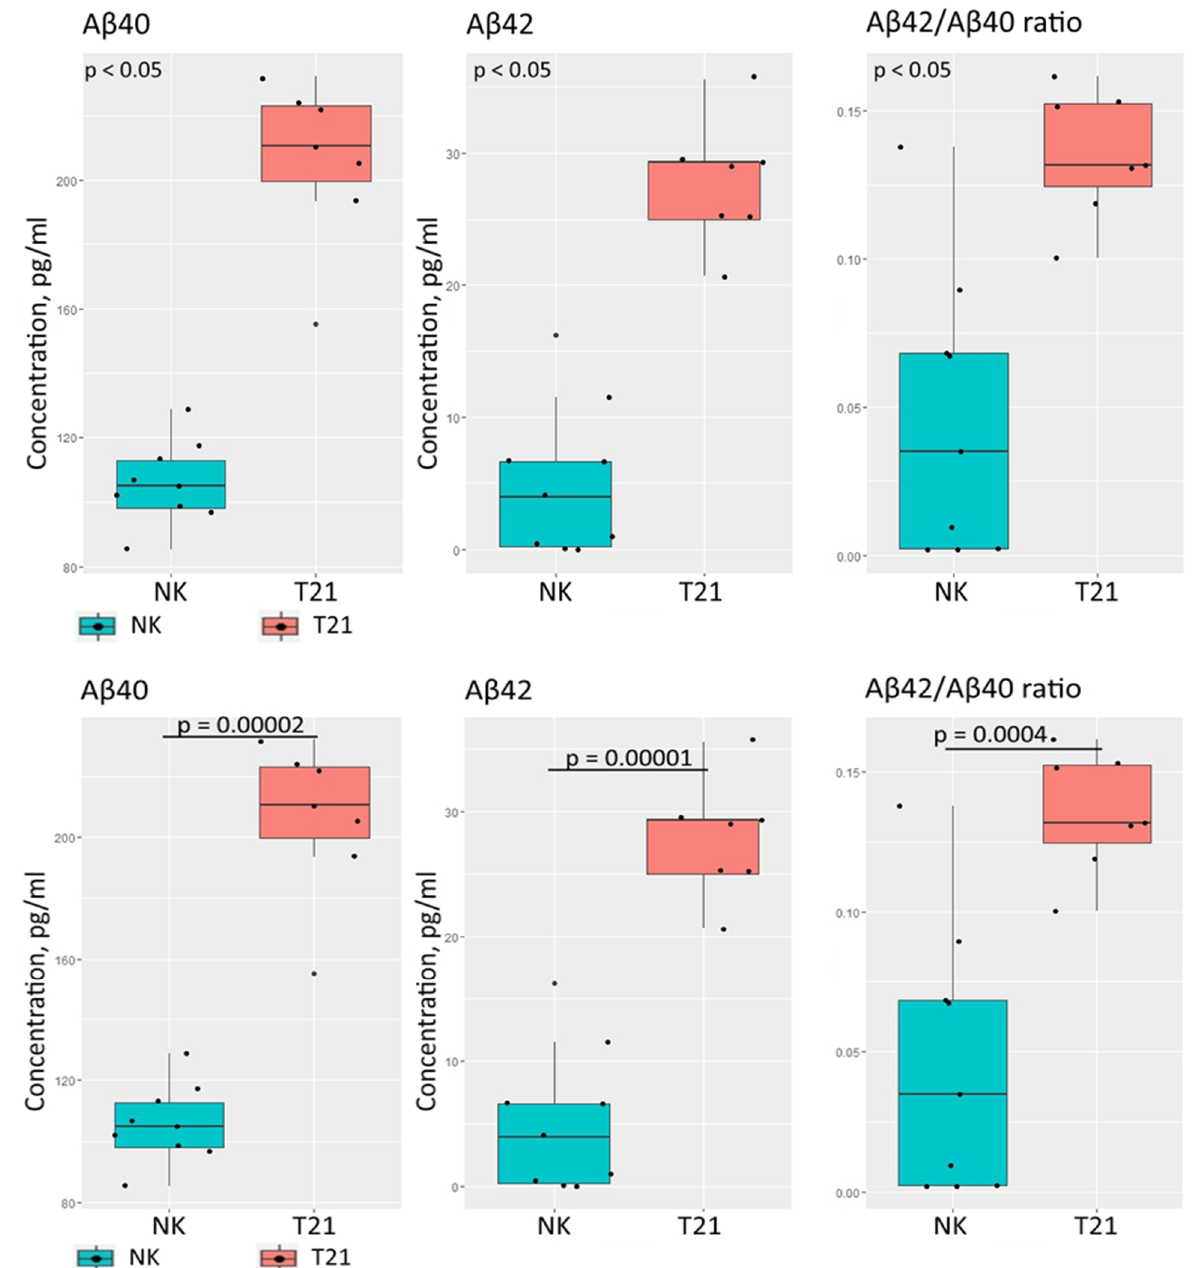
Figure 6. Immunofluorecent quantification of A β 40 and A β 42 in conditioned medium. TS21 spheroids secrete more A β 40 and A β 42. The proportion of A β 42 is higher in TS21 spheroids. The differences are statistically significant according to the T -test (for NK spheroids n = 9, for TS21 spheroids n = 7).